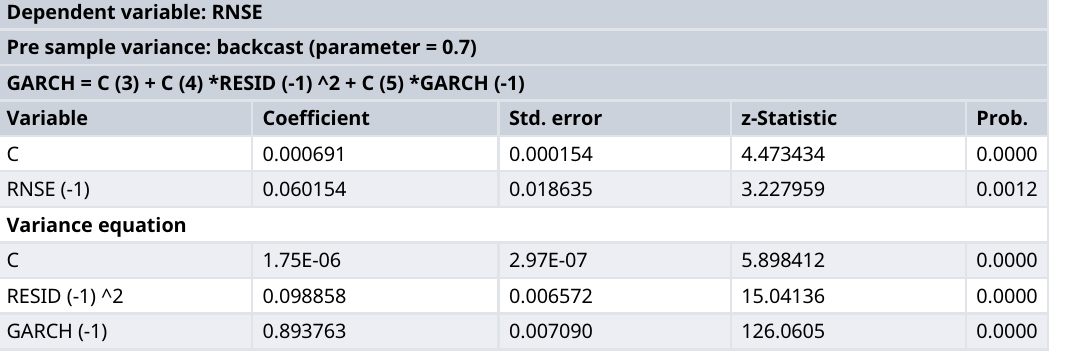
Table 3. GARCH (1,1) statistics for the daily returns of NSE. Dependent variable: RNSE Pre sample variance: backcast (parameter = 0.7)